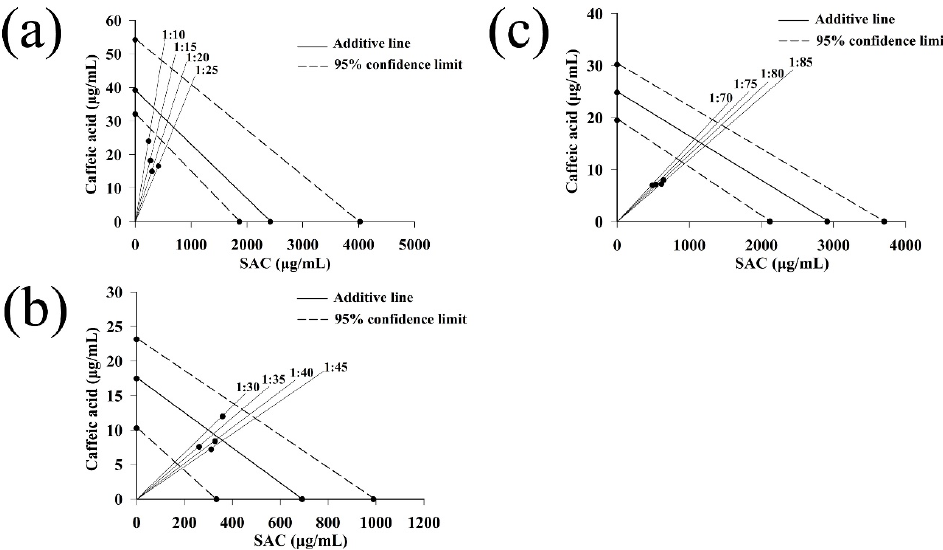
Figure 3. Isobologram for the mixture of caffeic acid and SAC in the DPPH, ABTS, and reducing power assays. ( a ) DPPH assay, ( b ) ABTS assay, ( c ) reducing power assay.